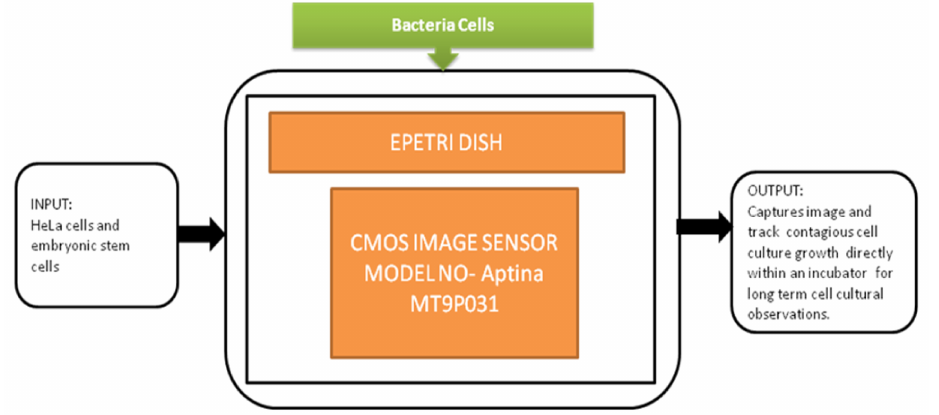
Figure 40. ePetri